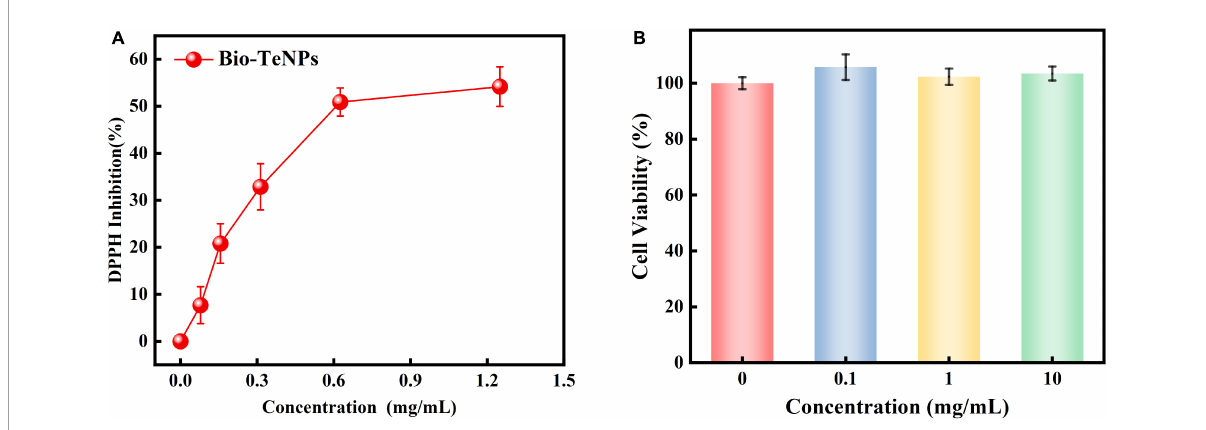
FIGURE9 Antioxidant activity (A) and cytotoxicity (B) of Bio-TeNPs at different concentrations. Data are shown as the mean ± SD of three biological